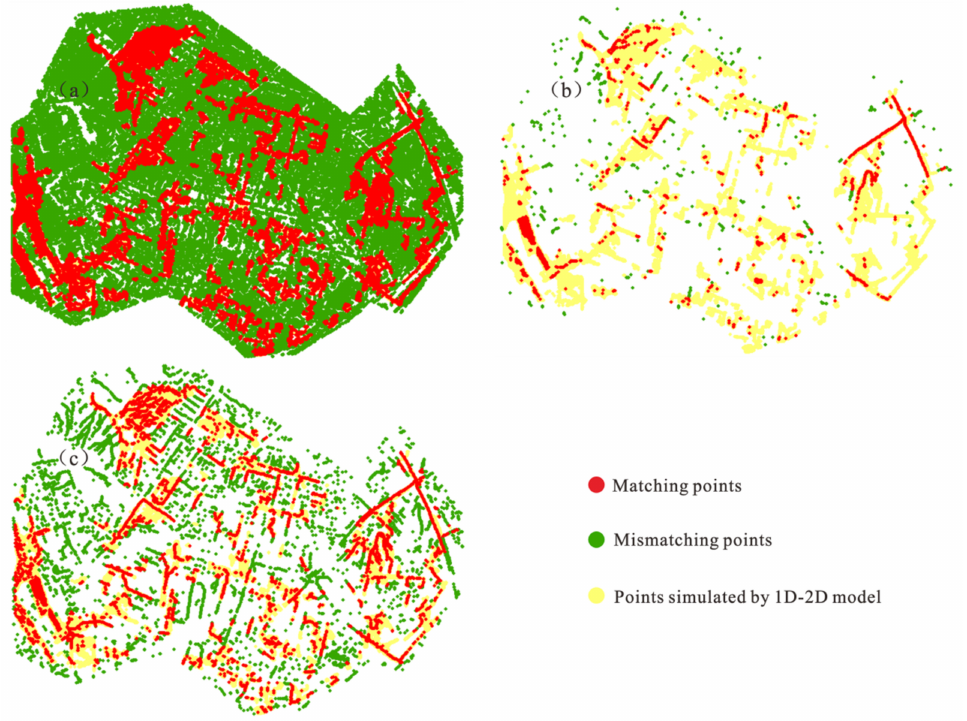
Figure 6. Spatial illustrations of flood maps using optimized TWI thresholds based on the ( a ) F1, ( b ) F2 and ( c ) F3 indicators. All points are shown on the 5.0 × 5.0-m